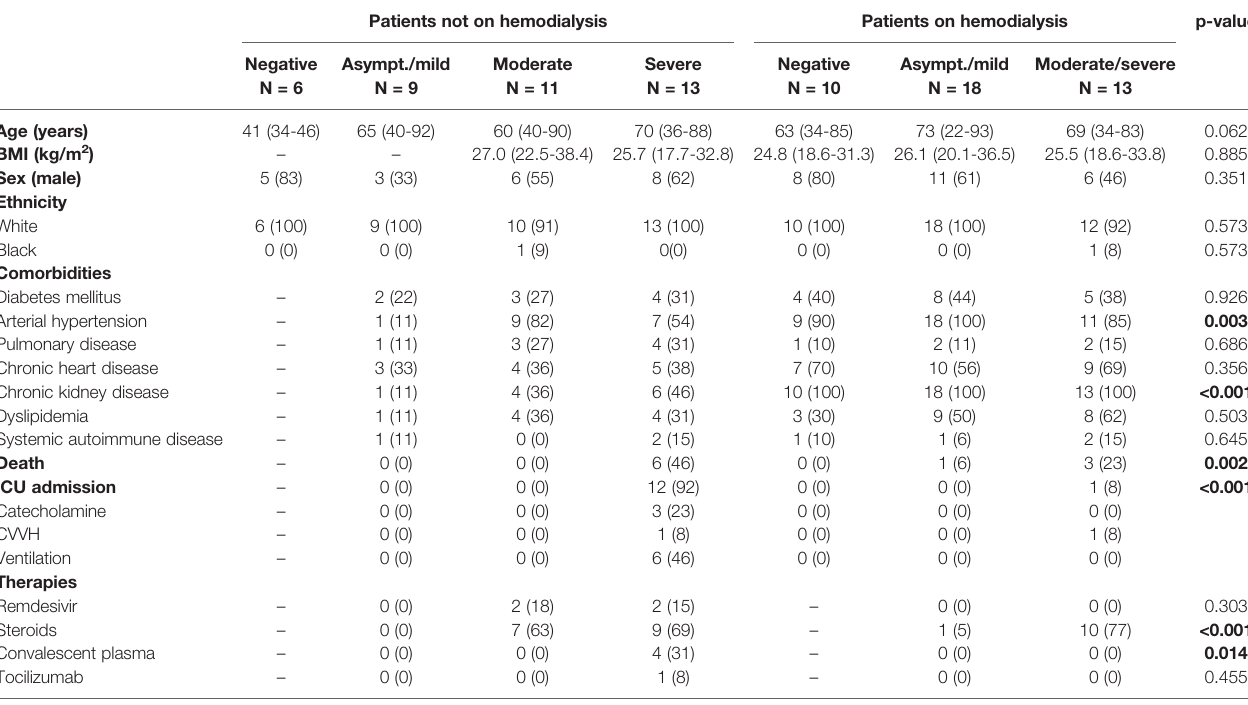
TABLE 2 | Clinical characteristics of the study participants without and with SARS-CoV-2